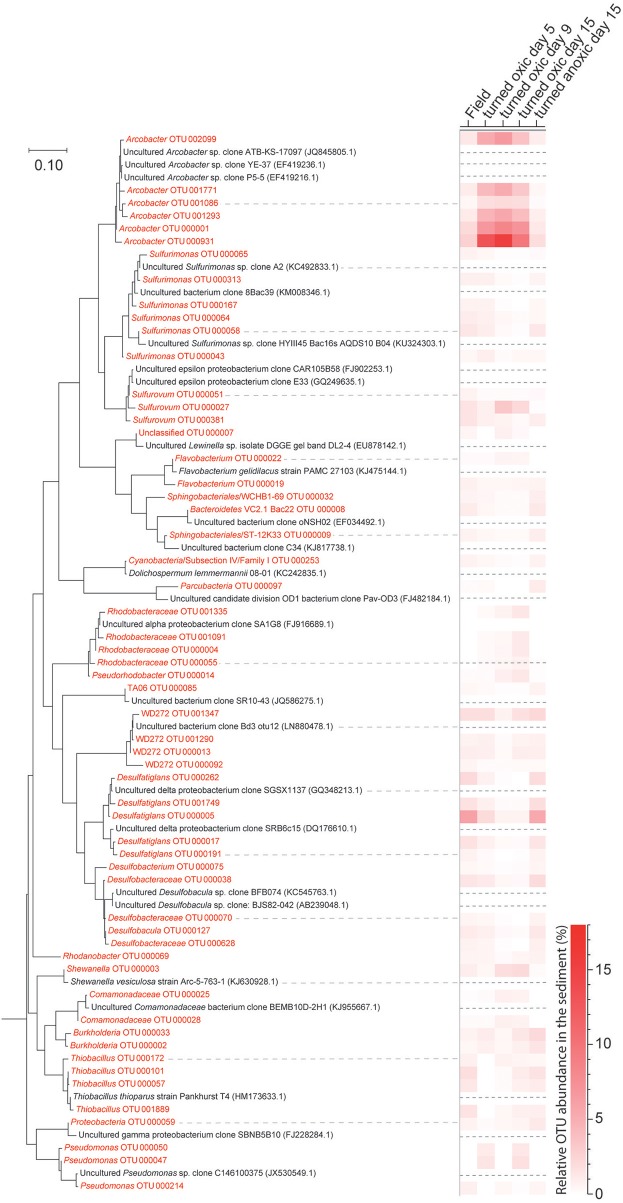
Phylogenetic maximum likelihood tree and the heatmap showing OTUs derived from the 16S rRNA gene analysis from collected sediment (top 1 cm) with a total relative abundance higher than 0.3% (average of all samples). Sequences from this study are colored red while reference sequences downloaded from NCBI Genebank are colored black and have been marked with a dashed line in the heatmap. A marine Actinomycete (NCBI accession: AJ866956.1) was used to root the tree (not shown) and the tree with the highest log likelihood (−7167.1443) is presented. The scale bar represents nucleotide substitutions per site.